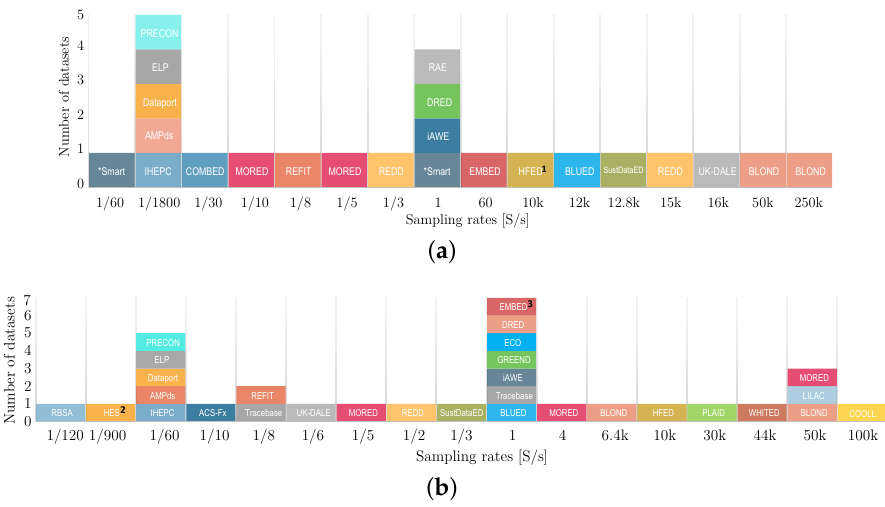
Figure 3. Histograms of a taxonomy based on the provided electricity consumption data and sampling rates. ( a ) Datasets providing WP and/or IC data; ( b ) Datasets providing IL data. 1 : Sampling rates of HFED are between 10k(S/s) and 5M(S/s); 2 : Sampling rate of HES is 1/120[S/s] or 1/300[S/s]; 3 : Sampling rate of EMBED is 1[S/s] or 2[S/s].